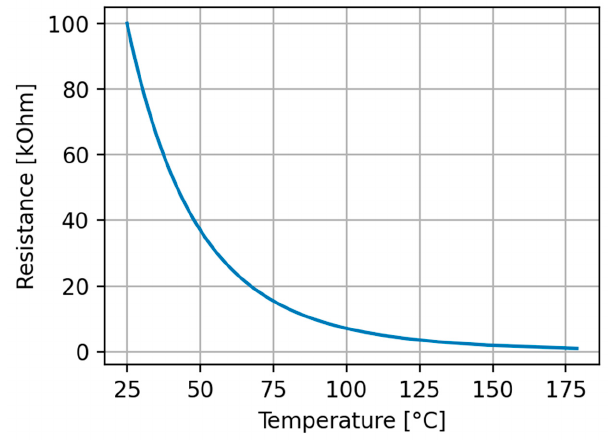
Figure 16. The full Steinhart–Hart Equation yields this temperature curve, showing the thermistor’s sensitivity decreasing as the temperature increases.